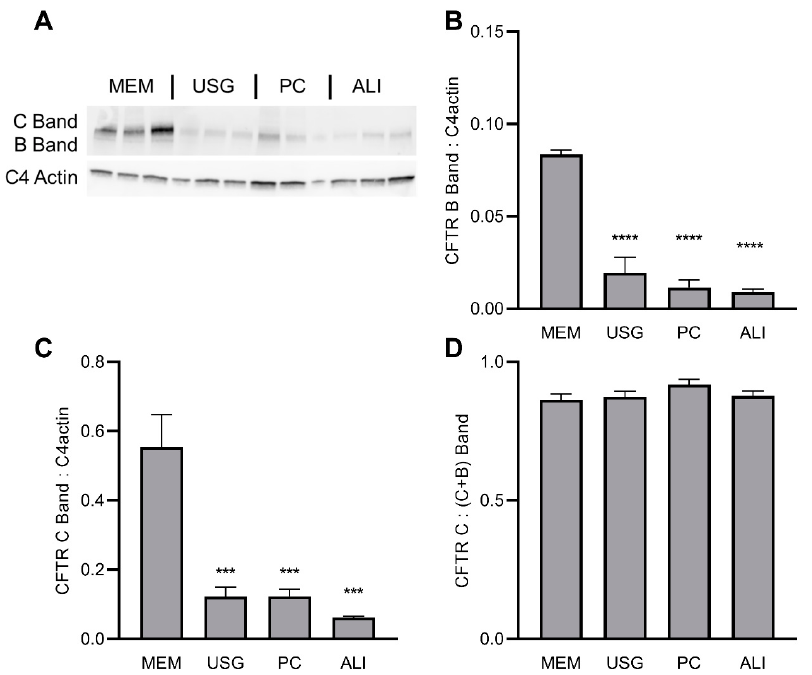
Figure 2. wtCFTR protein expression is increased in MEM media relative to USG, PC, and ALI media. Immunoblot for CFTR was performed and quantified for wtCFTR-expressing CFBE41o- cells ( A ). Densitometry was calculated relative to C4 actin and presented for Band B (immature) ( B ) and Band C (glycosylated) ( C ). The fraction of glycosylated wtCFTR protein (Band C/[Band C + Band B]) is quantified in ( D ). *** p < 0.001; **** p < 0.0001 vs. MEM by one-way ANOVA with Dunnett’s multiple comparisons correction.